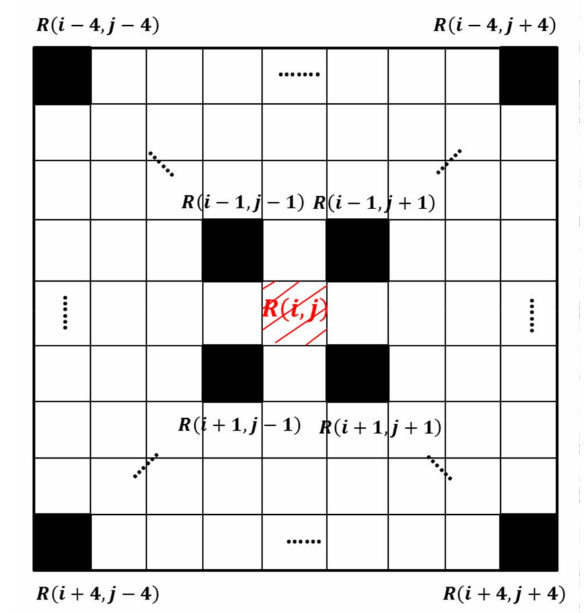
Figure 5. A 9 × 9 Gaussian window used to search for the dominant corner